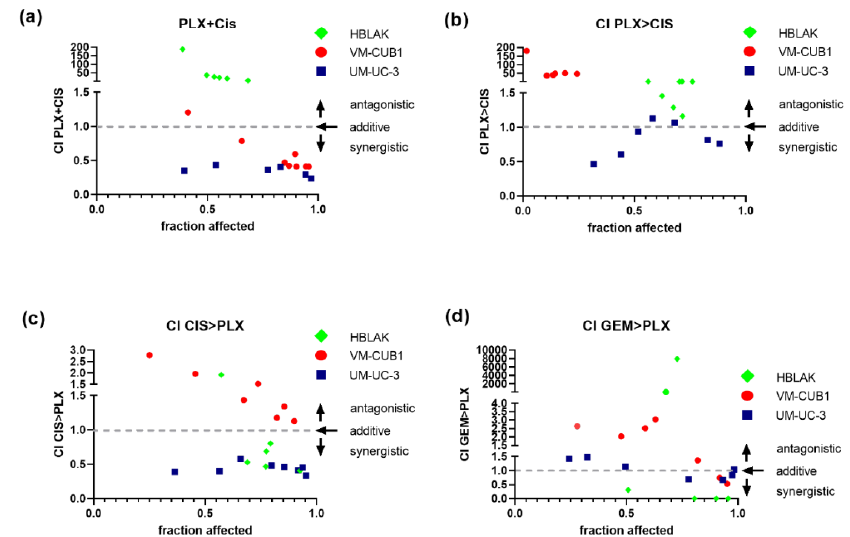
Figure 5. Synergistic effects of combination treatment with PLX and chemotherapeutic compounds on UCC. Cell viability was measured at constant dose ratios by MTT assay 72 h after the indicated simultaneous or sequential treatment (cell line-specific treatment dosages are given Table S4). Combination index (CI) plots for the combination of PLX and cisplatin (CIS) or gemcitabine (GEM) were calculated according to the Chou–Talalay method with Compusyn software. Combination index versus the number of dead cells (fraction affected) is displayed. CI < 1 indicates synergism (dashed line), CI = 1 additive effects and CI > 1 antagonism. ( a ) CI for simultaneous treatment with PLX and CIS, ( b ) CI for 24 h of pre-treatment with PLX followed by application of CIS for a further 48 h, ( c ) CI for 24 h of pre-treatment with CIS followed by the application of PLX for a further 48 h, ( d ) CI for sequential treatment with PLX and GEM are plotted. Green rhombi denote HBLAK, red circles VM-CUB1, and blue squares UM-UC-3 data points, respectively.